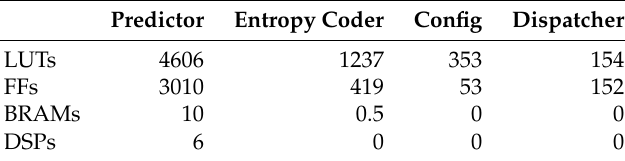
Table 4. FPGA resources used by each module of the CCSDS 123.0-B-1 IP core (AVIRIS image).